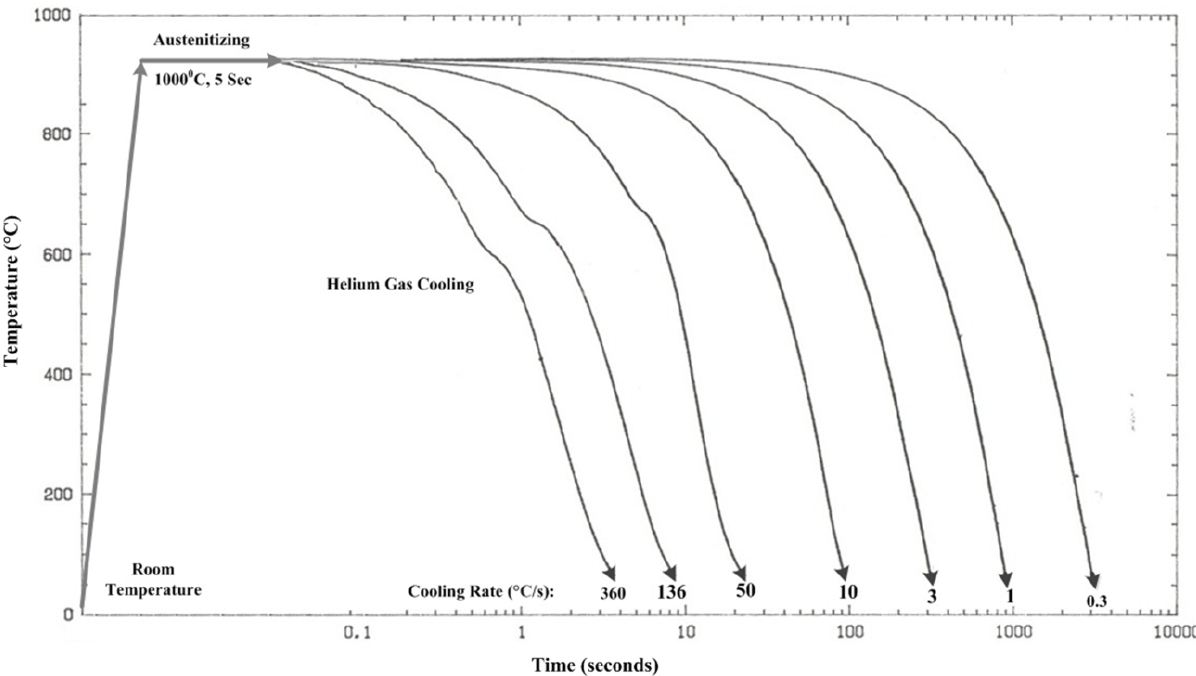
Figure 1: Schematic diagram of the heat treated cycles done by high-speed dilatometry on API X-60 samples in order to simulate weld simulation under different cooling